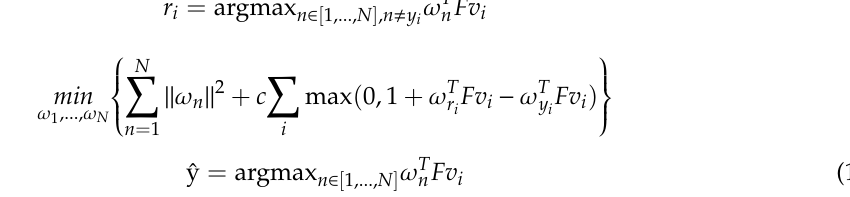
Figure 8. Standard leaf image of ICL dataset.